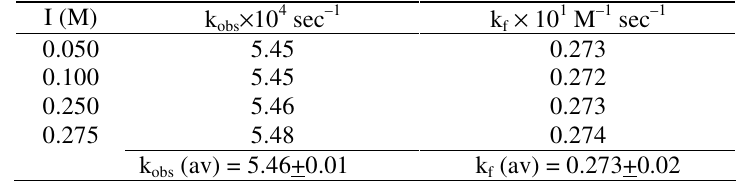
Table 3. Effect of ionic strength on the reaction of [Co II HDTA(H [Co II HDTA (H O)] 2– = 1.13 × 10 -3 M, ]IO[ 2 =